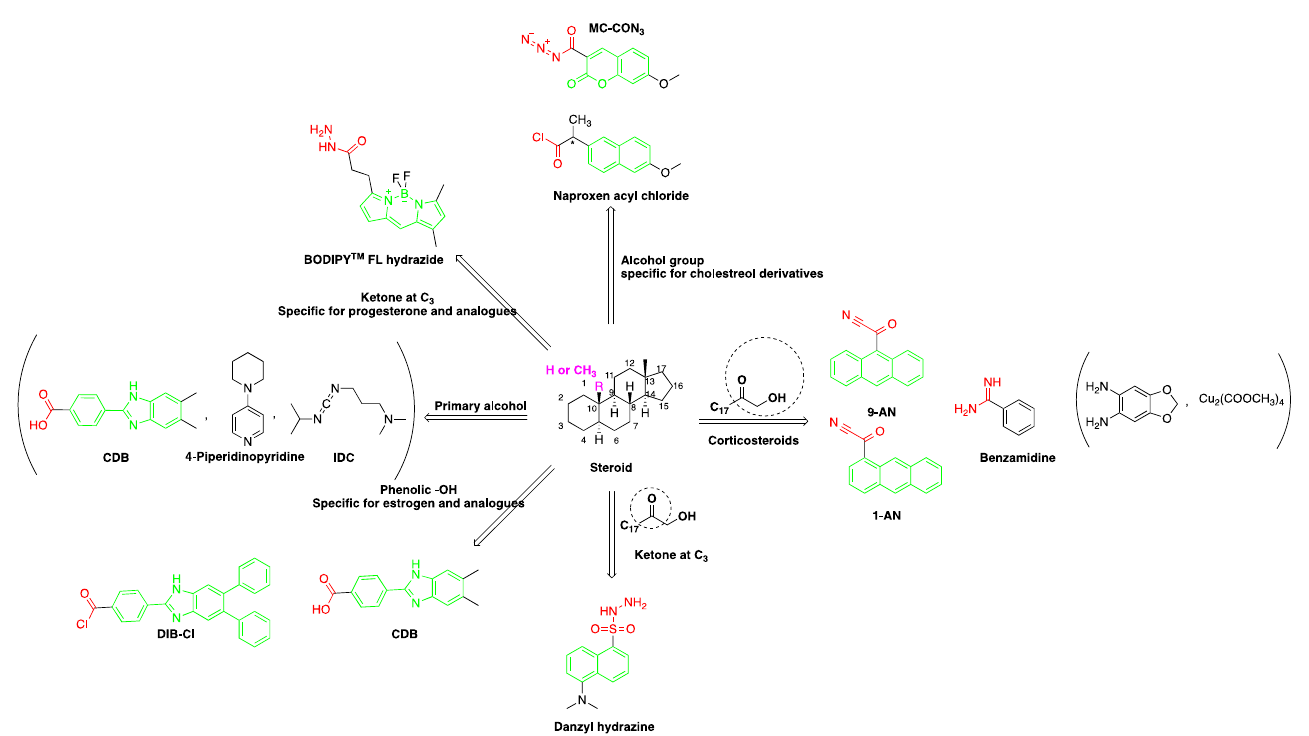
Figure 1. Representation of fluorescent derivatizing agents used in steroid analysis by HPLC-FLD.